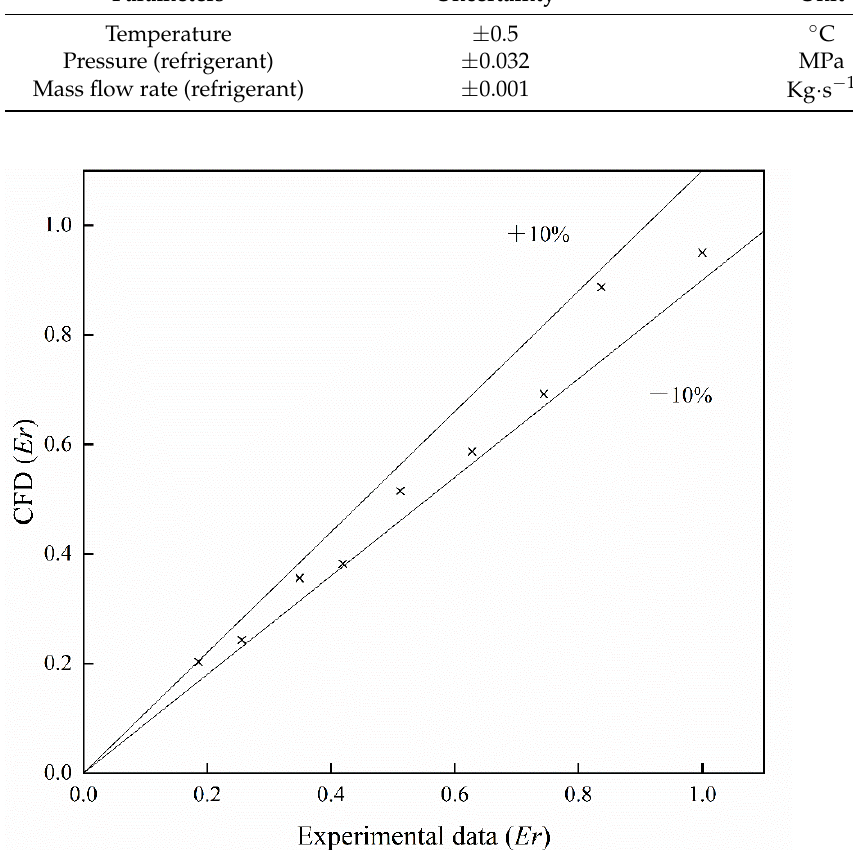
Figure 6. The comparison of Er between CFD and experimental data from the published literature [40]. ture [40].